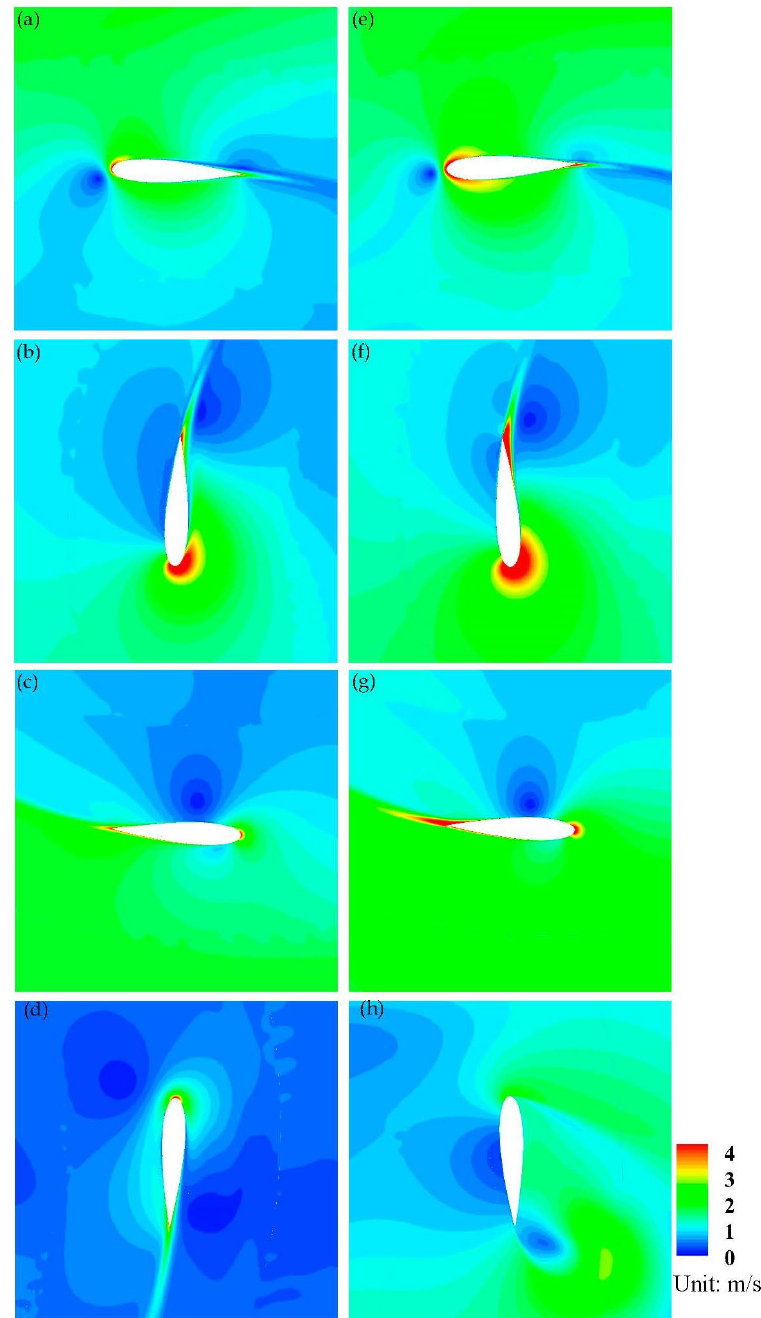
Figure 3. Comparison of velocity contours around a blade. Forced rotation: ( a ) 0 ◦ (360 ◦ ); ( b ) 90 ◦ ; ( c ) 180 ◦ ; ( d ) 270 ◦ ; Passive rotation: ( e ) 0 ◦ (360 ◦ ); ( f ) 90 ◦ ; ( g ) 180 ◦ ; ( h ) 270 ◦